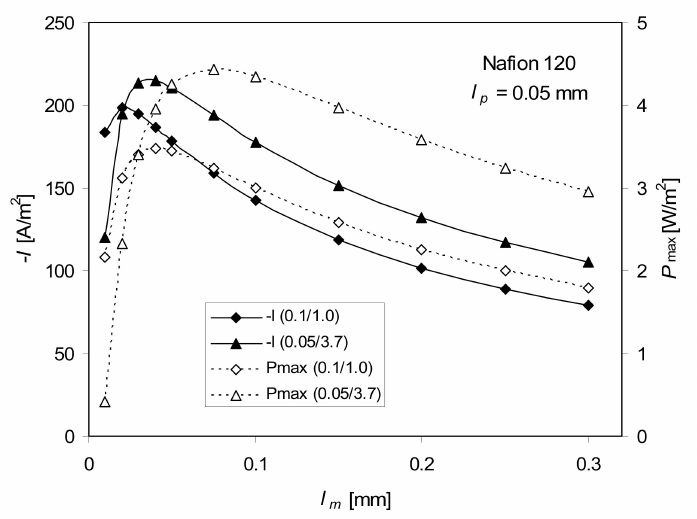
Figure 5. Dependence of the maximum of power density, P max , and the current density, − I , at P max on the membrane thickness, l m , for 0.1–1.0 M and 0.05–3.7 M NaCl, T = 298 K, Equation (5), full